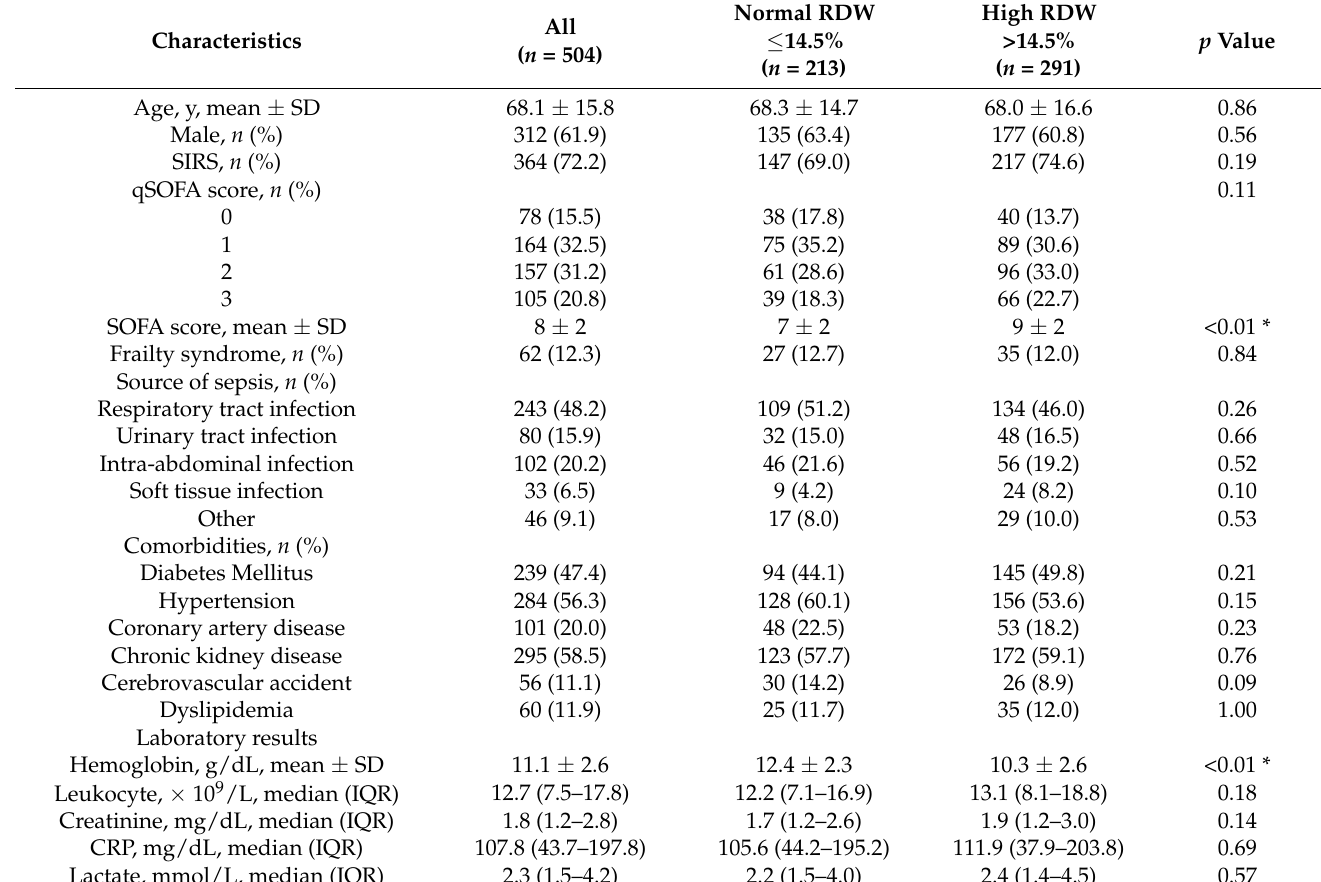
Table 1. Baseline characteristics of patients with sepsis based on their initial red cell distribution width ( n = 504).